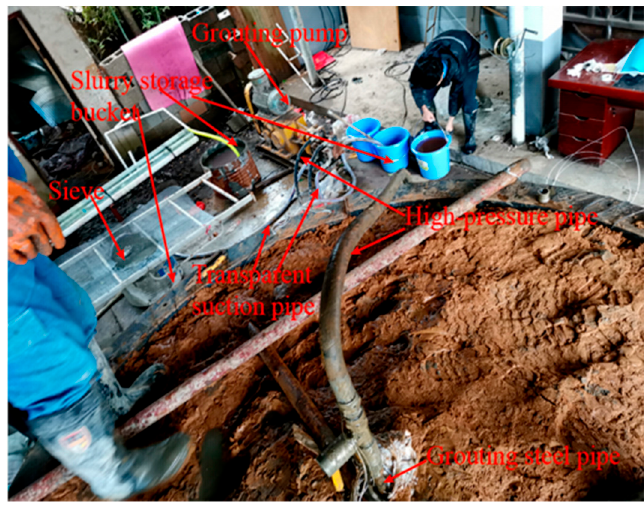
Figure 4. Grouting system equipment.